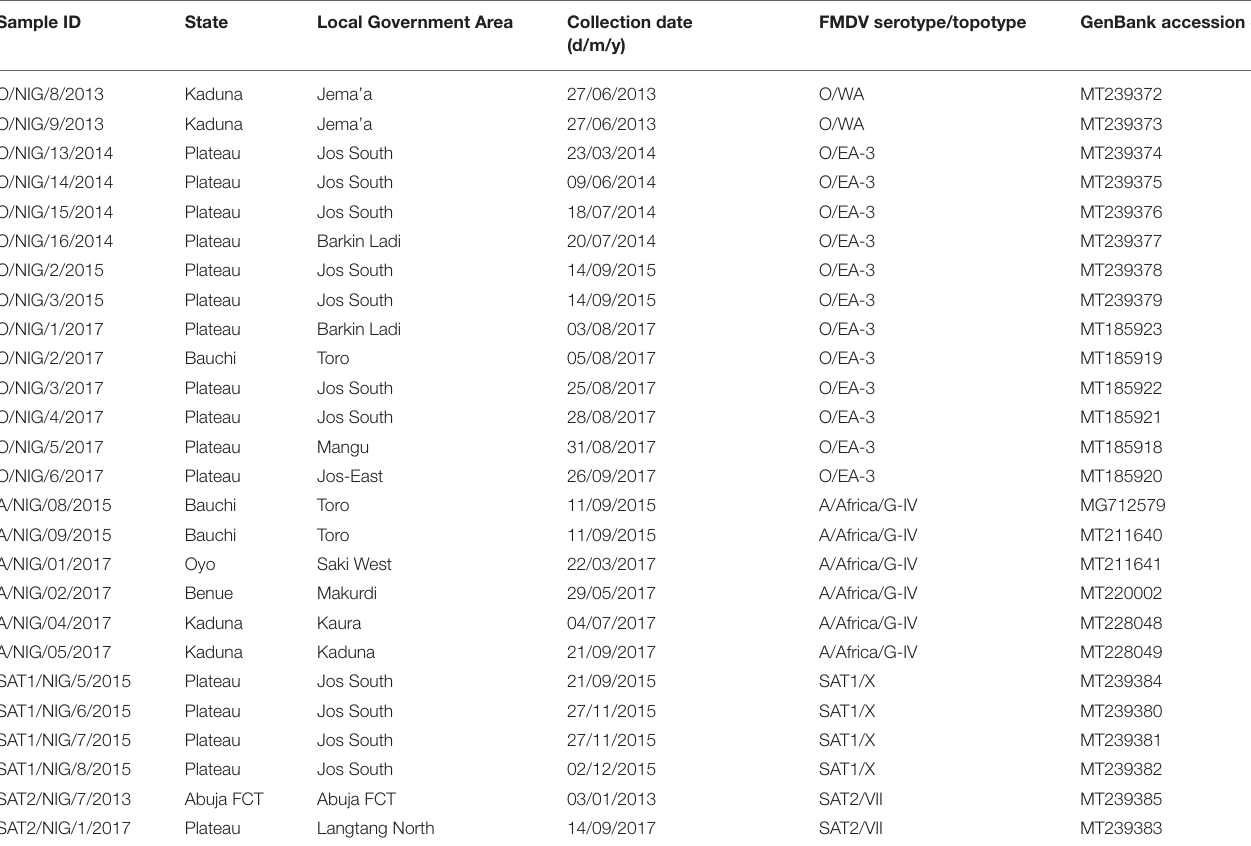
TABLE 1 | Summary of foot-and-mouth disease virus sequences from Nigeria obtained in the present study. Sample